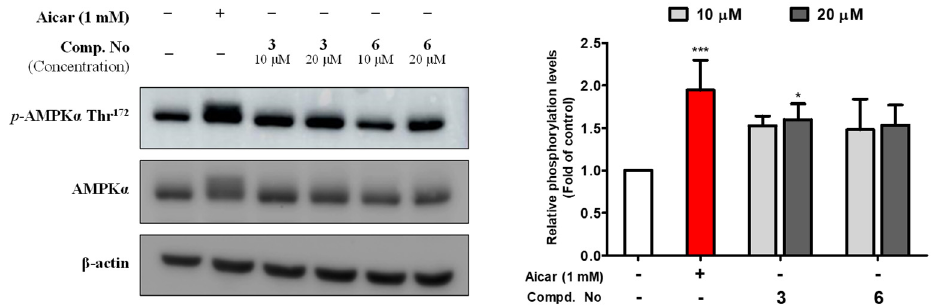
Figure 5. The effects of compounds 3 and 6 on the phosphorylation of the protein AMPK in differentiated C2C12 skeletal myoblasts. C2C12 cells were exposed to compounds 3 and 6 (10 and 20 μ M) or Aicar (1 mM) for 1 h. The phosphorylation of AMPK was detected by Western blot assay. The values are presented as the means ± SDs ( n = 3). * p < 0.05 and *** p < 0.001, compared to the negative control.